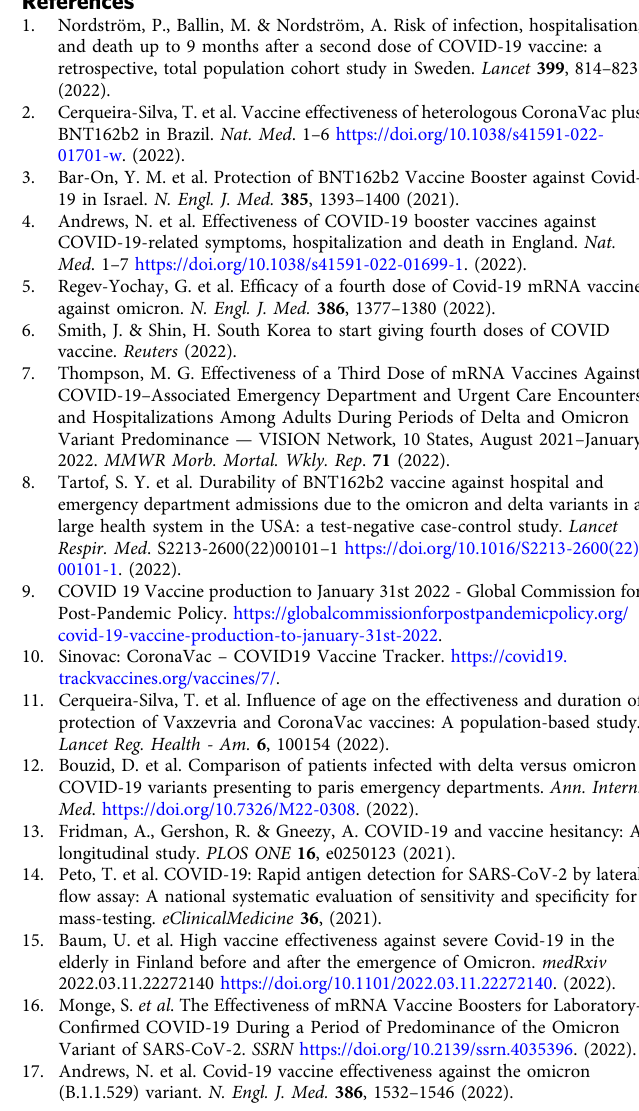
derived using generalized additive logistic regression, adjusting for potential confounders: age, sex, temporal trends, state of residence, previous infection, symptoms onset. Temporal trends and age were modeled as cubic regression spline smooth functions. The comorbidities were cardiac disease, diabetes